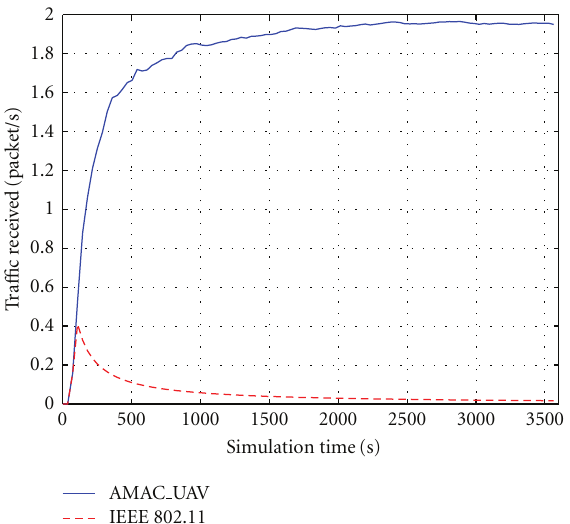
Figure 11: Receive BER of a MANET of 4 UAVs.